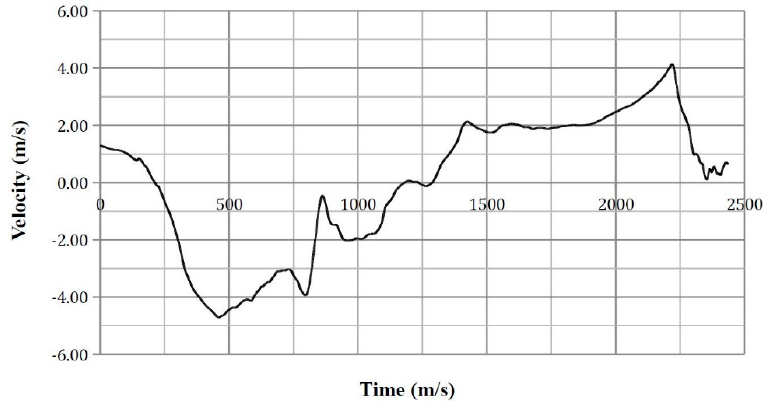
Figure A18. ATD Position 1 lower spine y-axis velocity.